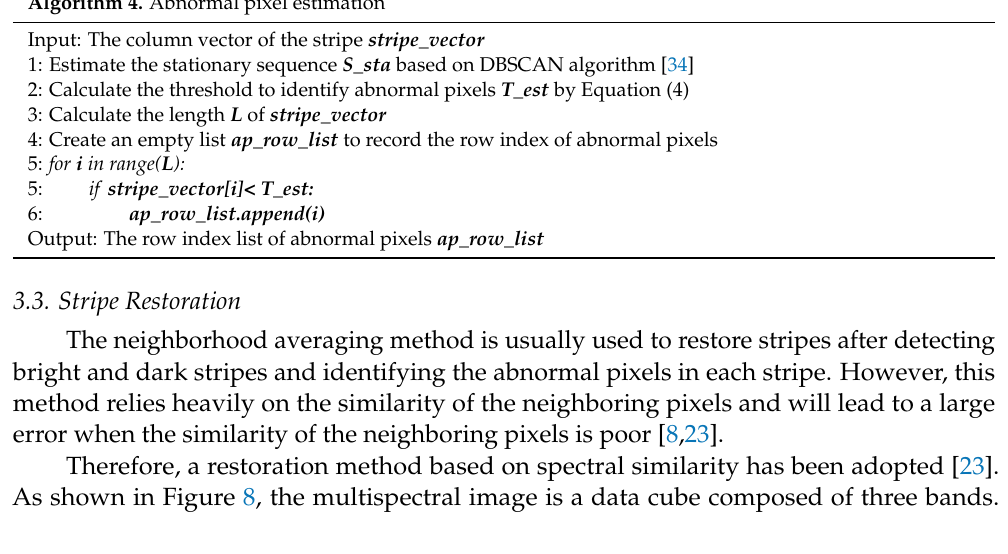
shown in Figure 3a.